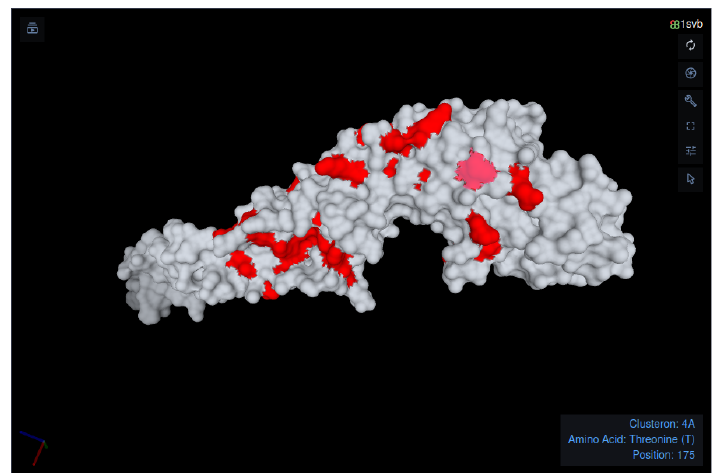
Figure 3. Visualization of the clusteron-specific amino acid signature on the surface of the E protein (PDB ID: 1SVB [25]). The visualization is generated by the PDBe Molstar application. The highlighted amino acids show the Baikalian subtype signature (CS ID: 4A).